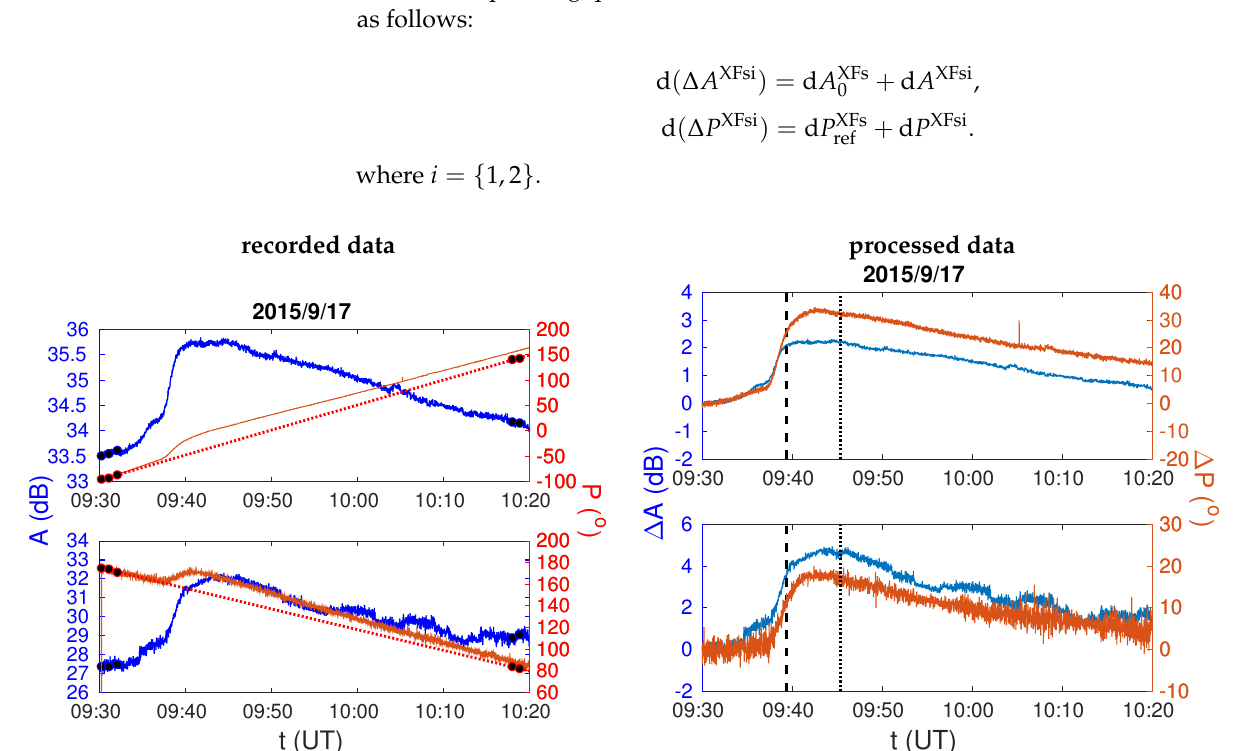
Figure 2. Time evolutions of the recorded amplitude and phase of DHO and ICV signals during the disturbance induced by the solar X-ray flare occurred on 17 September 2015 ( left panels ), and their deviations from the corresponding values in quiet conditions before the disturbance ( right panels ). The upper panels refer to the DHO signal, while the ICV signal data are shown in the bottom